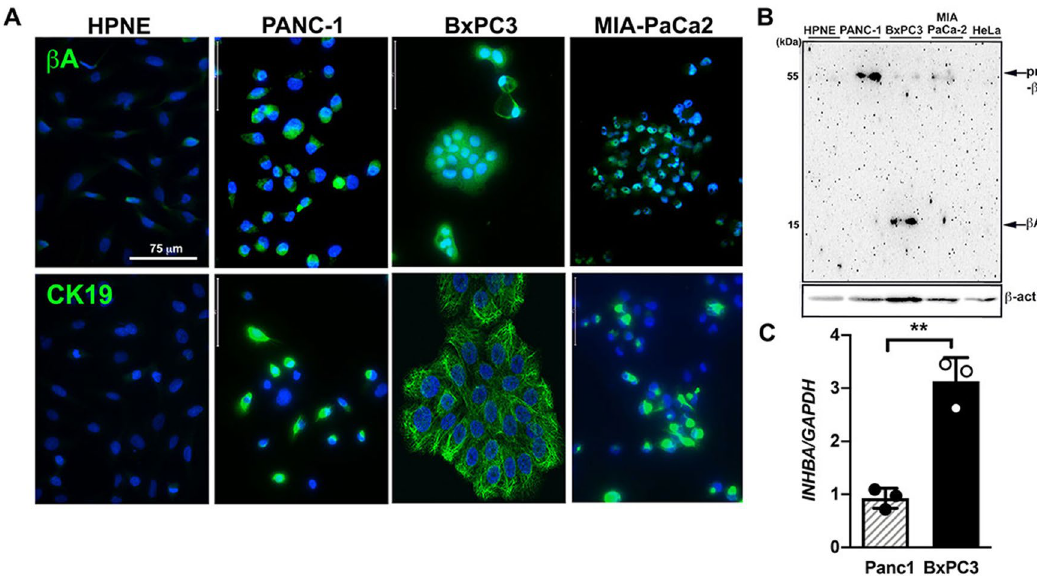
Figure 3. Activin A is highly expressed in tumor-derived cell lines from PDAC patients. ( A ) Immunofluorescence images of activin A (βA, top panels, AF488) and cytokeratin 19 (CK19, bottom panels, AF488) in hTERT-HPNE, PANC-1, BxPC-3 and MIA PaCa-2 cells. Nuclei were stained with DAPI. Scale bar = 75 µm. ( B ) Immunoblotting analysis of activin A expression in hTERT-HPNE, PANC-1, BxPC3, MIA PaCa-2 and HeLa cell lysates. ( C ) Relative INHBA mRNA expression levels in PANC-1 and BxPC-3